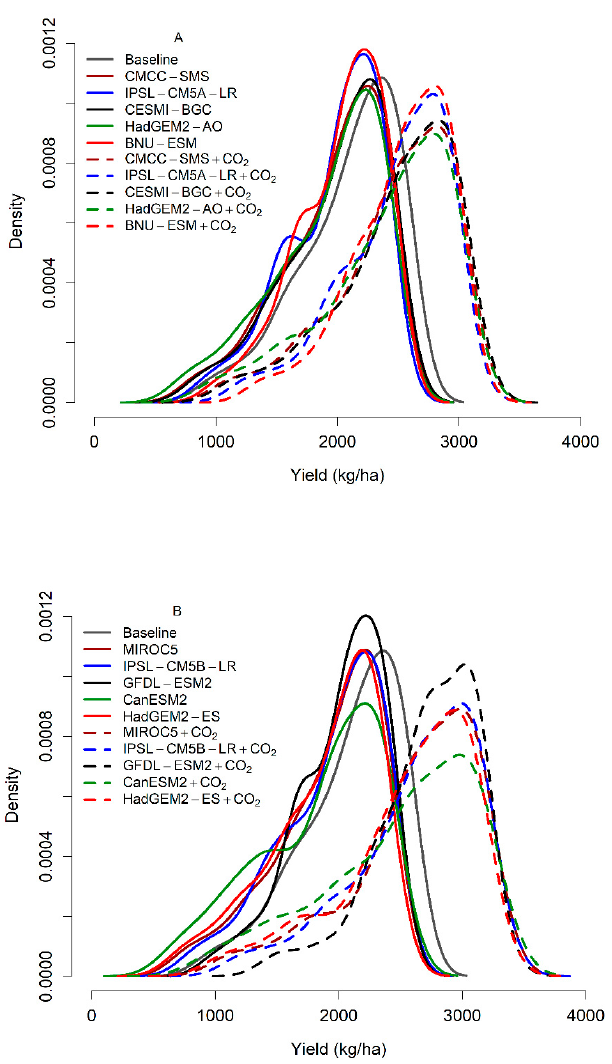
Figure 9. Distribution of simulated grain yield under ambient and elevated CO 2 conditions, two RCPs 4.5 ( A ) and 8.5 ( B ), each with 5 different climate scenarios. The variability in grain yields among farms under RCP 4.5 was between 18% and 23% and 16% and 21% with and without elevated CO 2 concentrations, respectively. In both cases, the hot wet scenario yielded the highest variability and lowest mean grain yields. Under RCP 8.5, simulated grain yields assuming ambient CO 2 resulted in yield declines as with RCP 4.5; thus, the distribution of yields under all GCMs were to the left (towards lower grain yields) of that of the baseline yields (Figure 9). As with RCP 4.5, the hot wet climate scenarios yielded the lowest mean grain yield among the climate scenarios irrespective of CO 2 concentration used, while the middle scenarios exhibited the highest grain yield. Simulated grain yields were between 1842 and 2011 kg/ha under ambient CO 2 concentrations and between 2497 and 2717 kg/ha under elevated CO 2